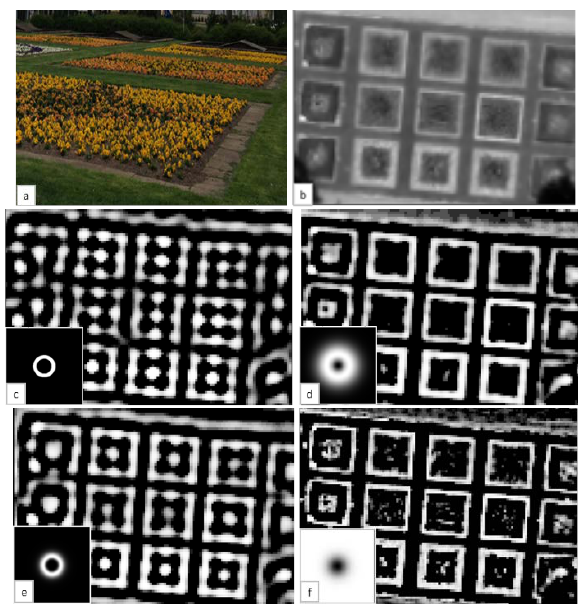
Figure 3. Different filters and their effects (with a closer look of the parterre area); (a) is a photo of the parterre area taken in the field; (b) is the original grayscale image; (c) is the ideal band- pass filtered image (cut-off range from 100 to 150); (d) is the Gaussian band-pass filtered image (cut-off range from 100 to 150); (e) is the Butterworth band-pass filtered image (cut-off range from 100 to 150); (f) is the high-pass filtered image (cut- off range size of